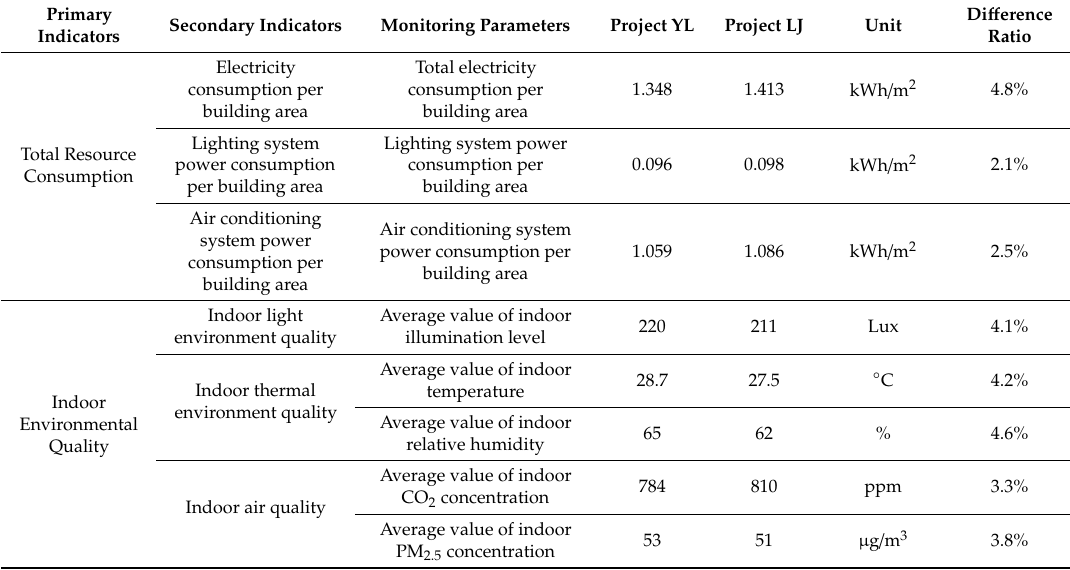
Table 12. The monitoring data of conventional indicators for two case projects.